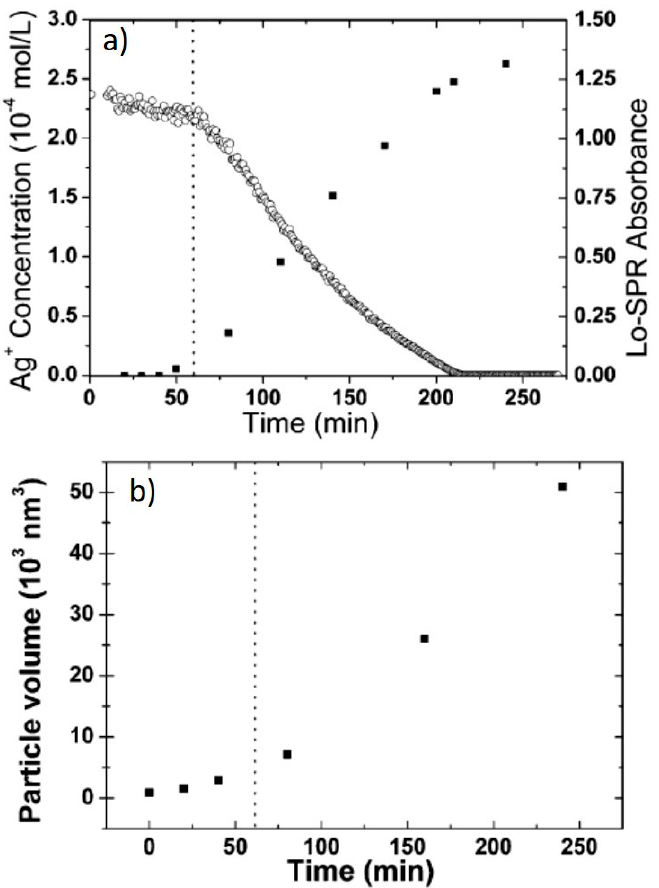
Figure 5. ( a ) Ag+ concentration evolution over time; ( b ) particle volume evolution over time, as estimated from TEM images. Adapted with permission from ref. [29]. Copyright 2007 American Chemical Society.